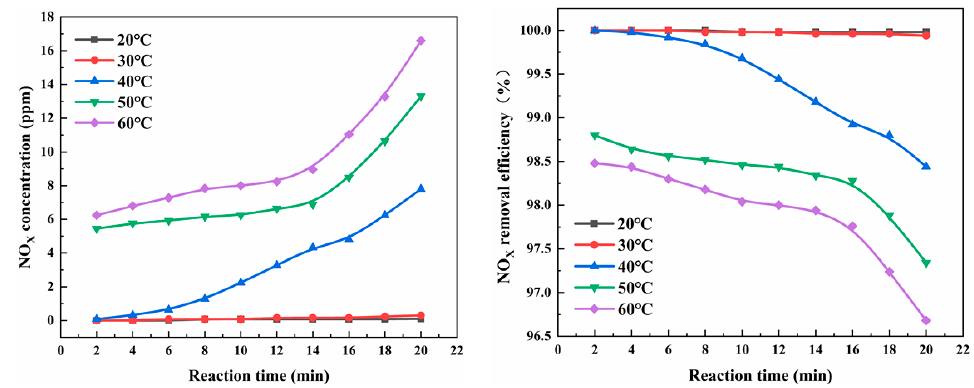
Figure 6. Effects of solution temperature on NO X removal efficiency.